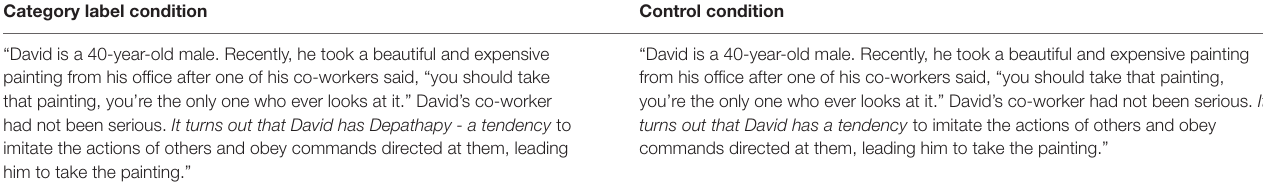
TABLE 1 | An example of experimental material. Category label condition Control